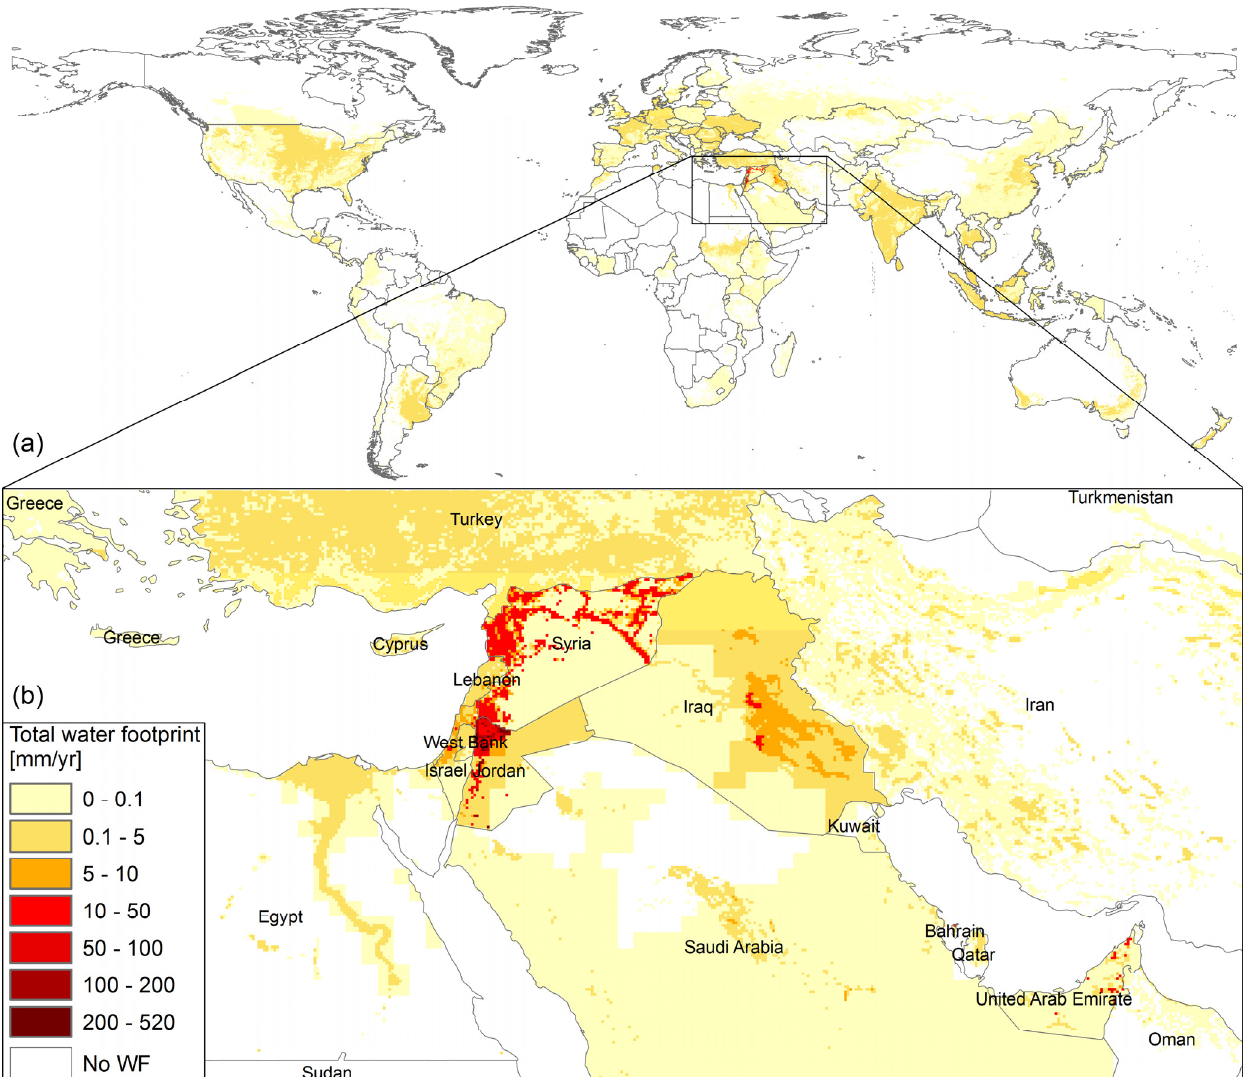
Figure 3. The global water footprint of Jordan’s consumption ( a ) and an enlarged view of the Middle East ( b ). Both follow the legend depicted in ( b ). Period: 1996–2005. Data based on